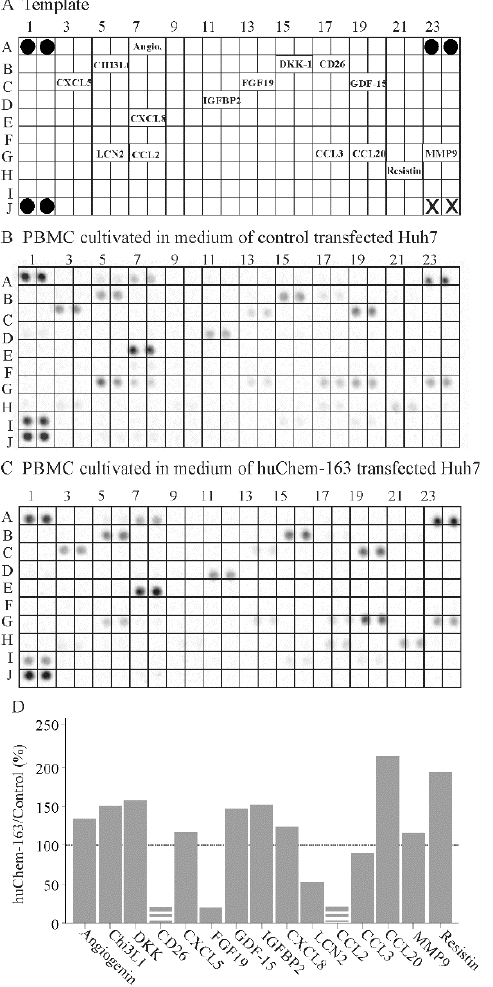
Figure 8. Cytokine array of peripheral blood mononuclear cells (PBMC)s exposed to supernatant of huChem-163 expressing or control-transfected Huh7 cells: ( A ) Template of the array. The soluble factors detected are given at the respective position of the array. Black circles represent the reference spots and X the positions where no antibody was spotted. ( B ) Array hybridized with media of PBMCs cultivated in supernatant of control-transfected Huh7 cells. ( C ) Array hybridized with media of PBMCs cultivated in supernatant of huChem-163 expressing Huh7 cells. ( D ) Arrays were quantified with ImageJ, and the ratios of huChem-163/control stimulated cells are shown. The broken bars were used when the respective cytokine was not detectable on the array shown in ( C ) and the extent of downregulation could not be calculated. The dotted line marks 100%. n = 1. Angiogenin = Angio.